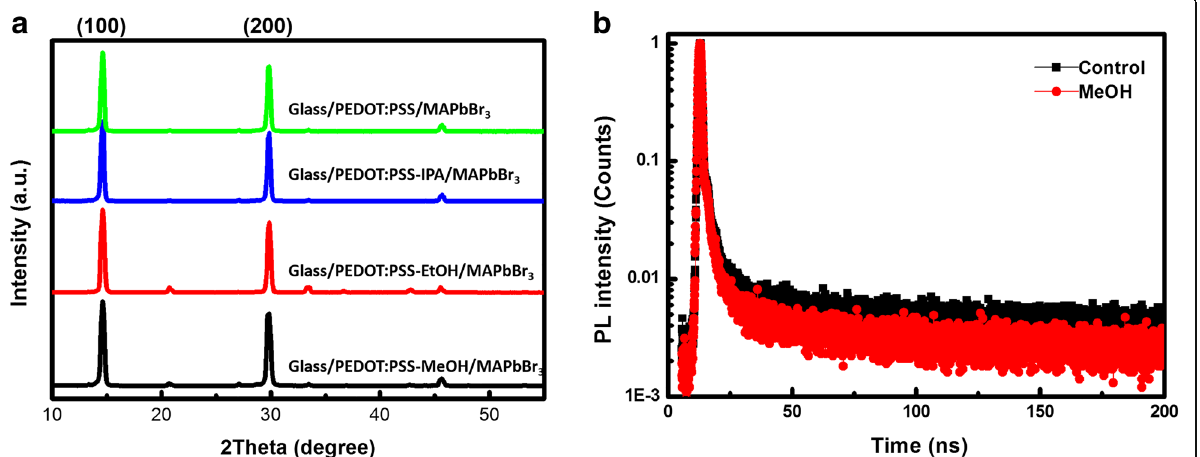
Fig. 7 a XRD images of MAPbBr 3 films and b time-resolved PL lifetime of MAPbBr 3 films on PEDOT:PSS films with and without MeOH